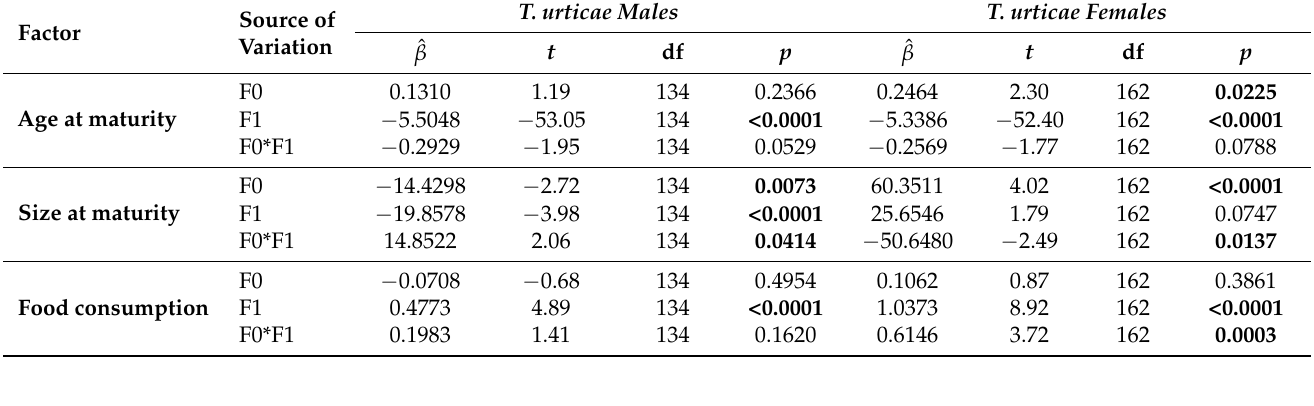
Table 3. Heat wave effects (mild or extreme heat waves) on age and size at maturity, and the food consumption of offspring (F1) deriving from T. urticae parents experiencing either mild or extreme heat wave conditions (F0). p -values in bold indicate a significant effect ( p < 0.05). Data were analyzed by a mixed ANOVA (PROC GLM in SAS) using F0 as a random factor and F1 as a fixed factor. The parameters associated with F0 ( β 1 ), F1 ( β 2 ), and F0*F1 ( β 3 ) indicate the relative contribution of